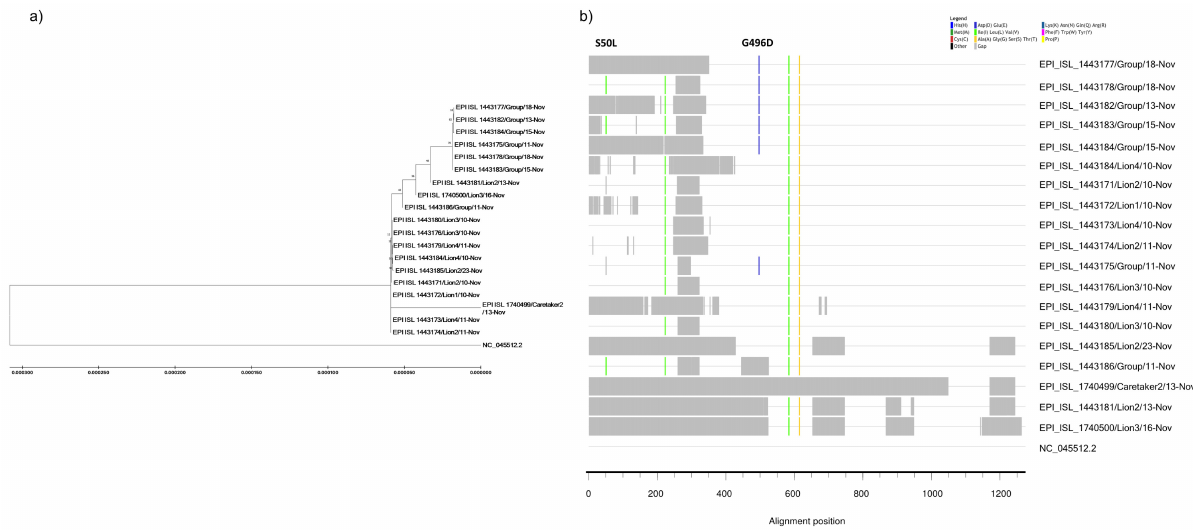
Figure 3. Whole-SARS-CoV-2 genome sequencing and phylogenetic and comparative analyses. ( a ) Maximum likelihood phylogenetic analysis of the genomic sequences obtained from lion respiratory and fecal specimens at different time-points after infection was detected, as well as a nasopharyngeal sample from a lion caretaker, using the Hasegawa–Kishino–Yano model. The reference SARS-CoV-2/Wuhan-Hu-1 isolate (NCBI accession number: NC_045512.2) was included as an outgroup of the analysis. The tree with the highest log likelihood ( − 34294.32) is shown. The percentage of trees in which the associated taxa clustered together is shown next to the branches. The phylogenetic tree is drawn to scale, with branch lengths measured in the number of substitutions per site. ( b ) Amino acid comparative sequence analysis of the spike protein of SARS-CoV-2. The panel shows mismatches (gray boxes) of the sequences obtained from lion respiratory and fecal specimens obtained throughout the study, as well as its respective caretaker, compared to the reference NC_045512.2 sequence. Comparative analyses determined the emerging mutations S50L and G496D specifically in fecal samples, whose positions have been pointed out in the plot. Colored lines in each position of the alignment show amino acid differences and sequencing gaps found among the different analyzed samples according to the legend. Abbreviations: C2, lion